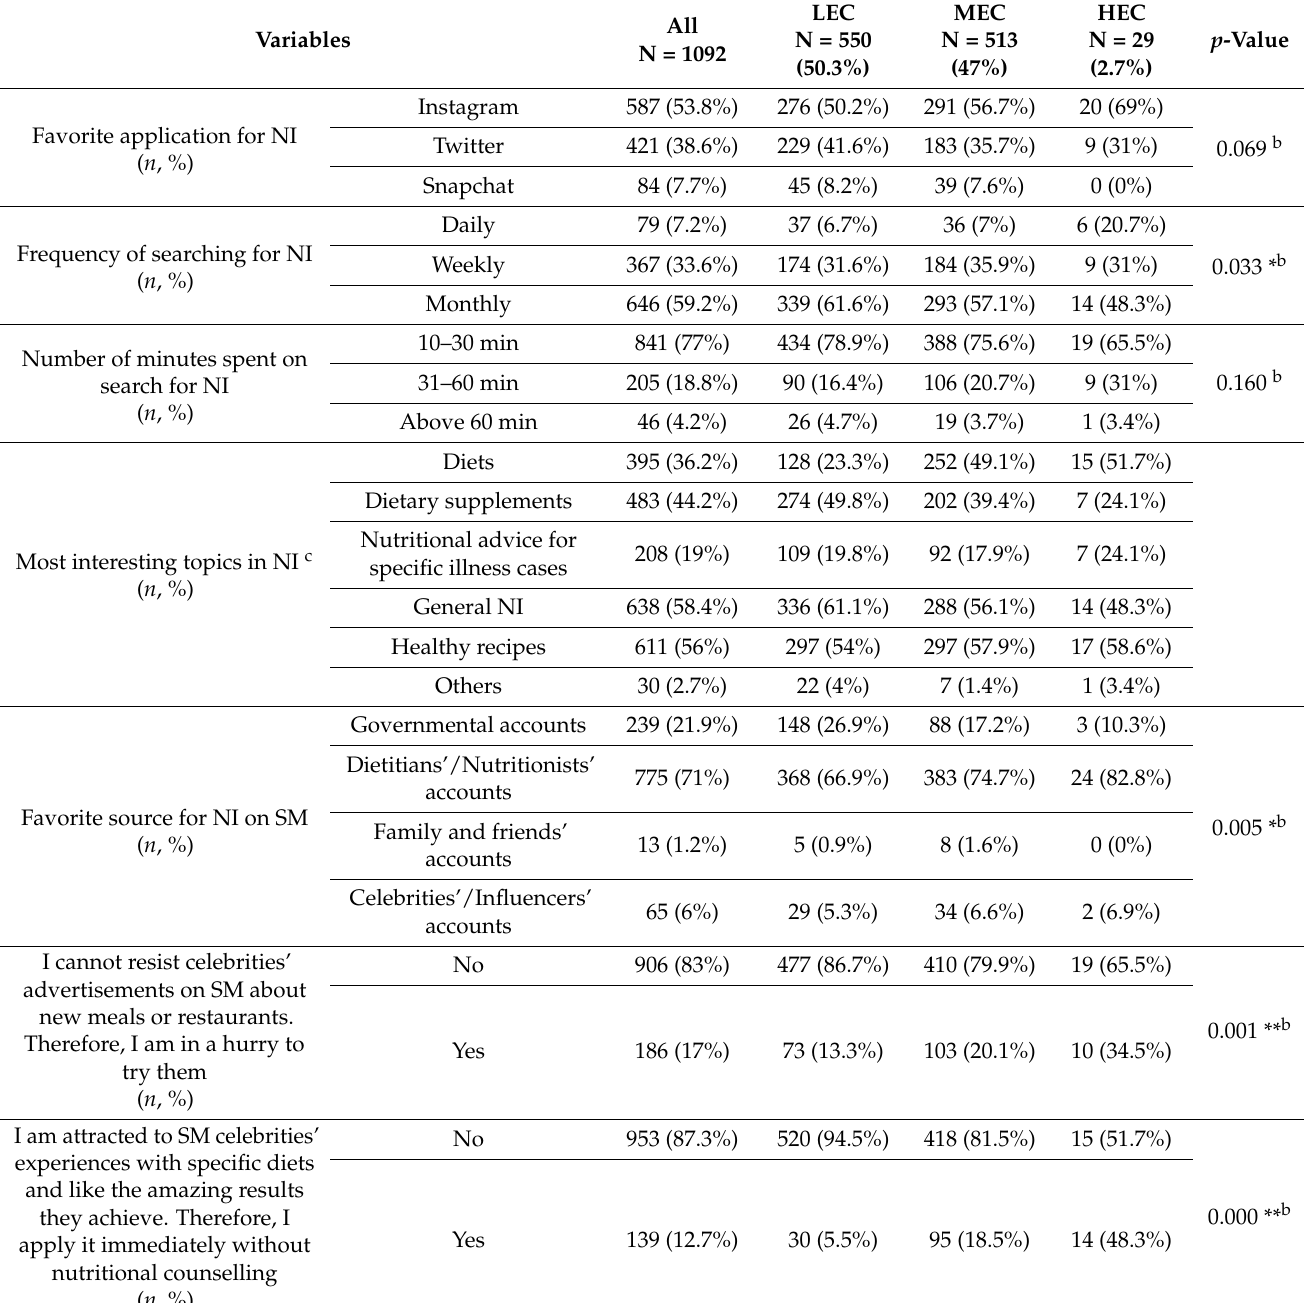
Table 3. Nutritional Information Search